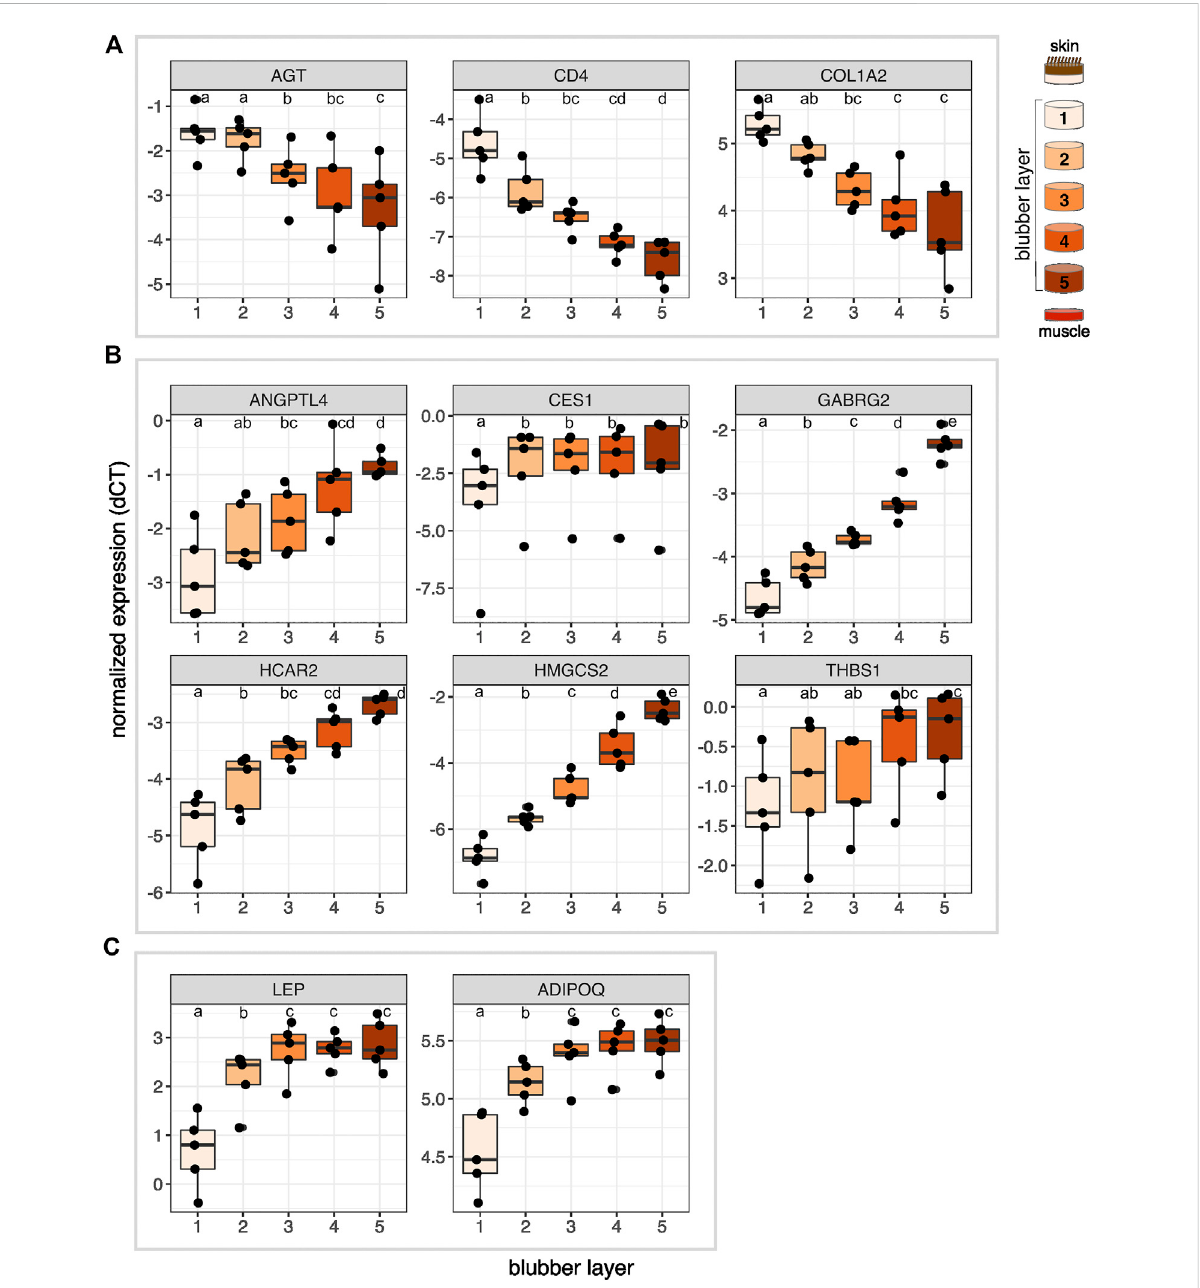
FIGURE 5 Normalized expression (delta C T ) of 11 genes of interest across fi ve layers of blubber of northern elephant seal pups ( n = 5). Target genes were (A) identi fi edasupregulated inouterblubber, (B) identi fi edas upregulatedininnerblubberbytranscriptomics,andincluded (C) twoadipokine genes ofinterest.Differentlettersdenoteexpressionlevelsthatweresigni fi cantlydifferent( p < 0.05)betweenlayers. AGT ,angiotensinogen; CD4 ,clusterof differentiation 4; COL1A2 , collagen alpha-2(I) chain; ANGPTL4 , angiopoietin-related protein 4; CES1 , carboxylesterase 1; GABRG2 , gamma- aminobutyric acid receptor subunit gamma-2; HCAR2 , hydroxycarboxylic acid receptor 2; HMGCS2 , hydroxymethylglutaryl-CoA synthase, mitochondrial; THBS1 , thrombospondin-1; LEP , leptin; ADIPOQ ,